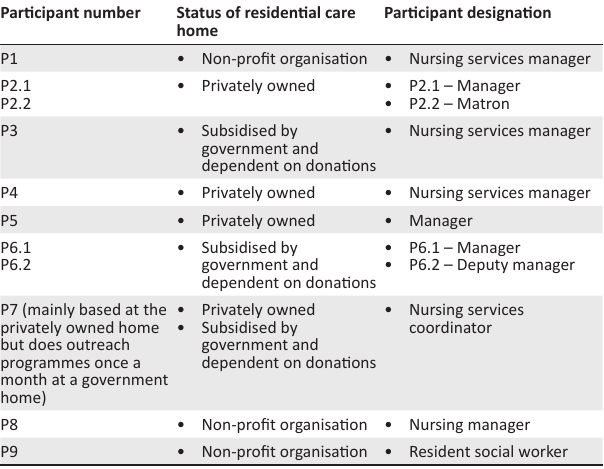
TABLE 1: Participants’